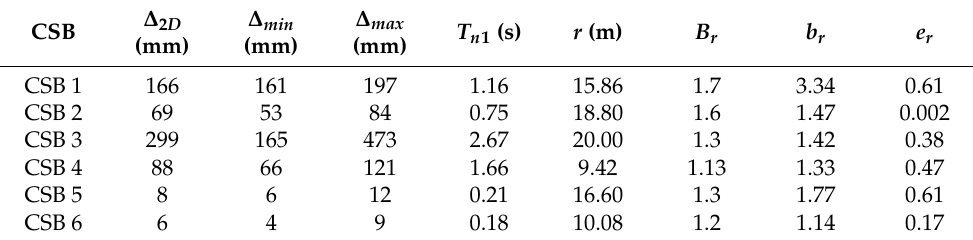
Figure 17. 2D quasi-static displacement profiles of the case study buildings obtained from SPACE GASS (by applying horizontal equivalent static design forces calculated as per [30]). Table 2. Effective displacements, effective natural period, and torsional parameters of the six case study buildings (CSB) for the critical direction of seismic action.